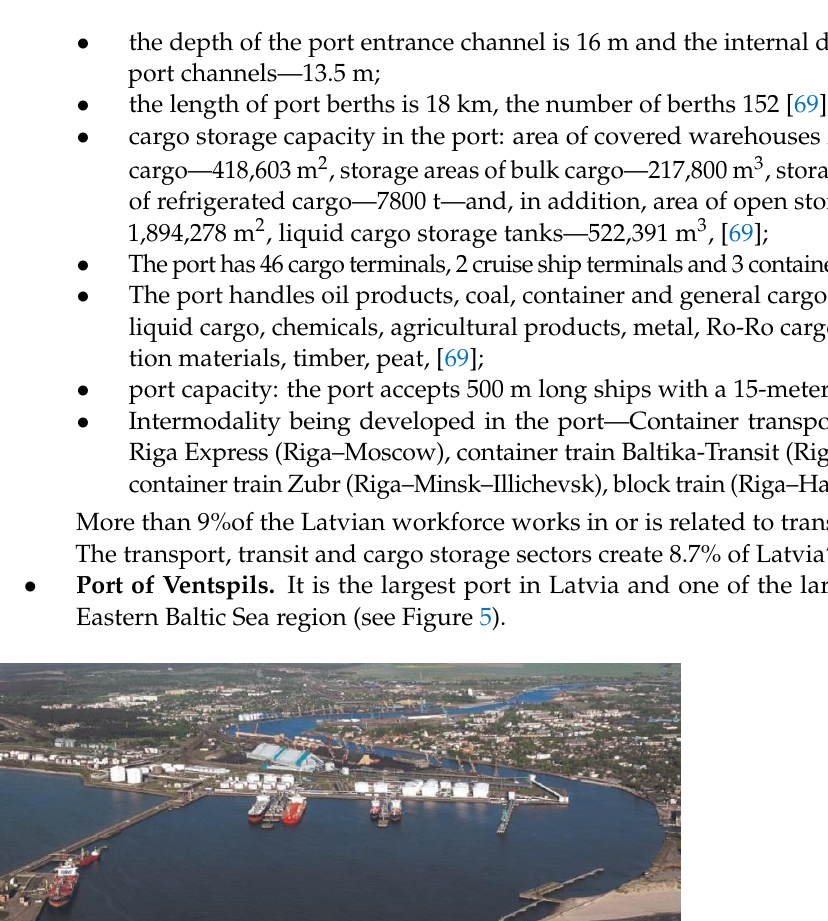
Figure 6. Port of Liepaja. Source: [72]. The main characteristics of the port are as follows: • the port now covers an area of 2451.39 ha, which consists of the land area of 2208.79 ha and the internal water area of the port covering 242.60 ha;